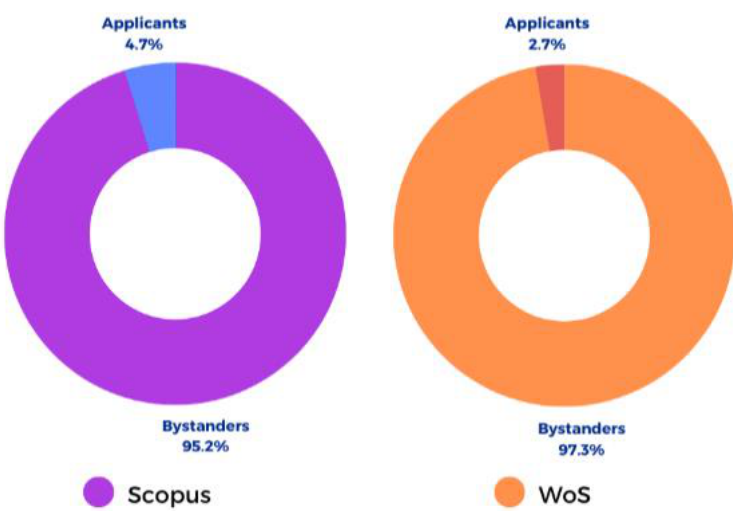
Figure 5. Authors classification Crane system. Source: Authors’ own data.